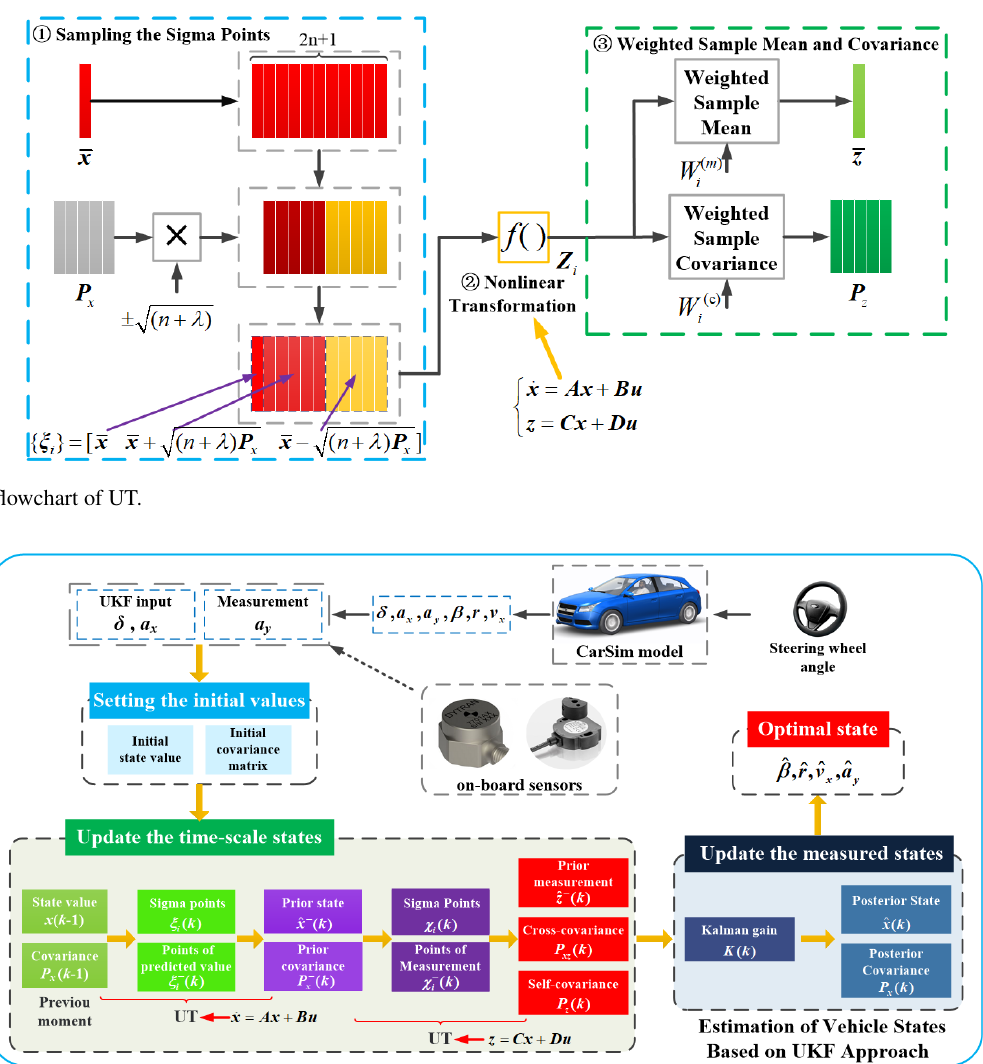
Figure 3. The estimation flowchart of vehicle states based on the UKF